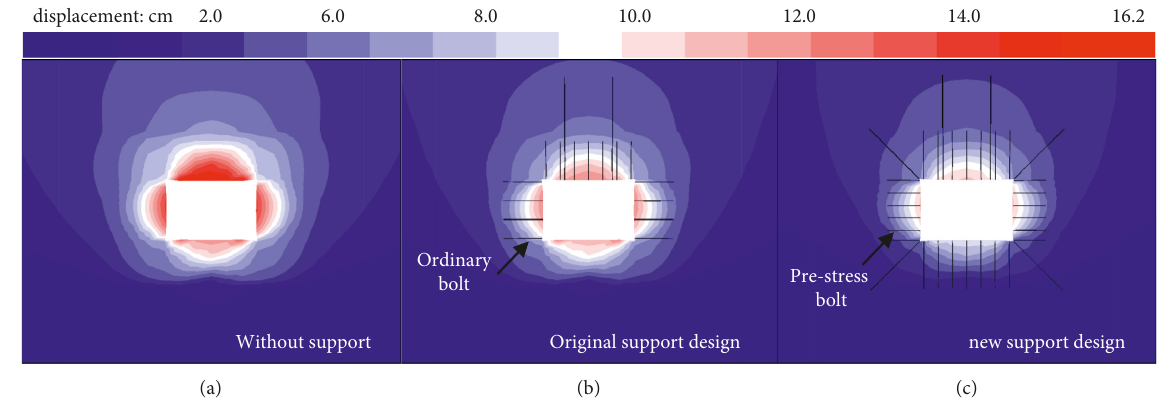
Figure 8: Displacement of roadway surrounding rock mass under different